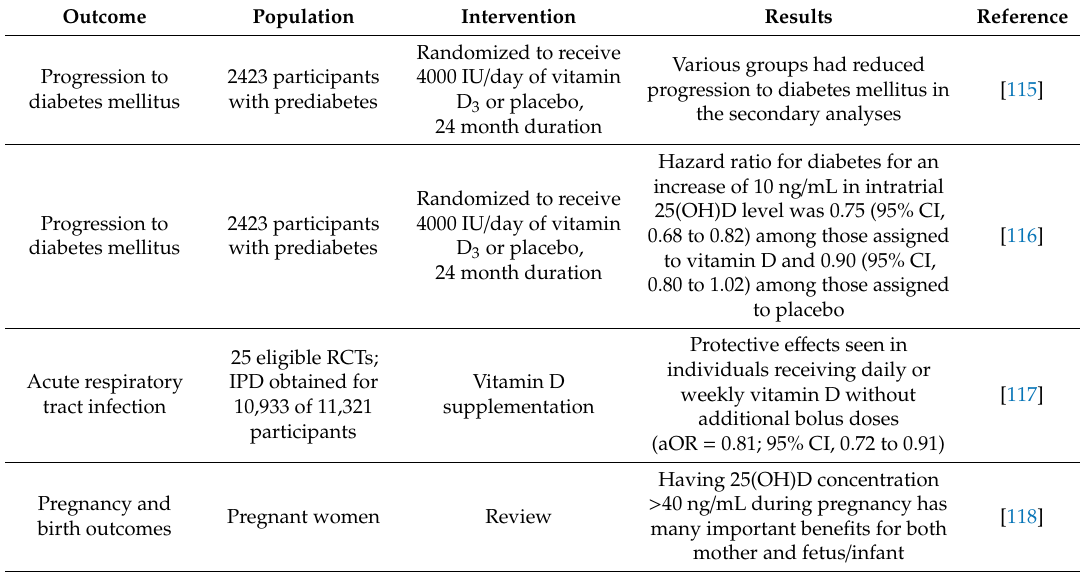
Table 2. Evidence for beneficial e ff ects of vitamin D for selected